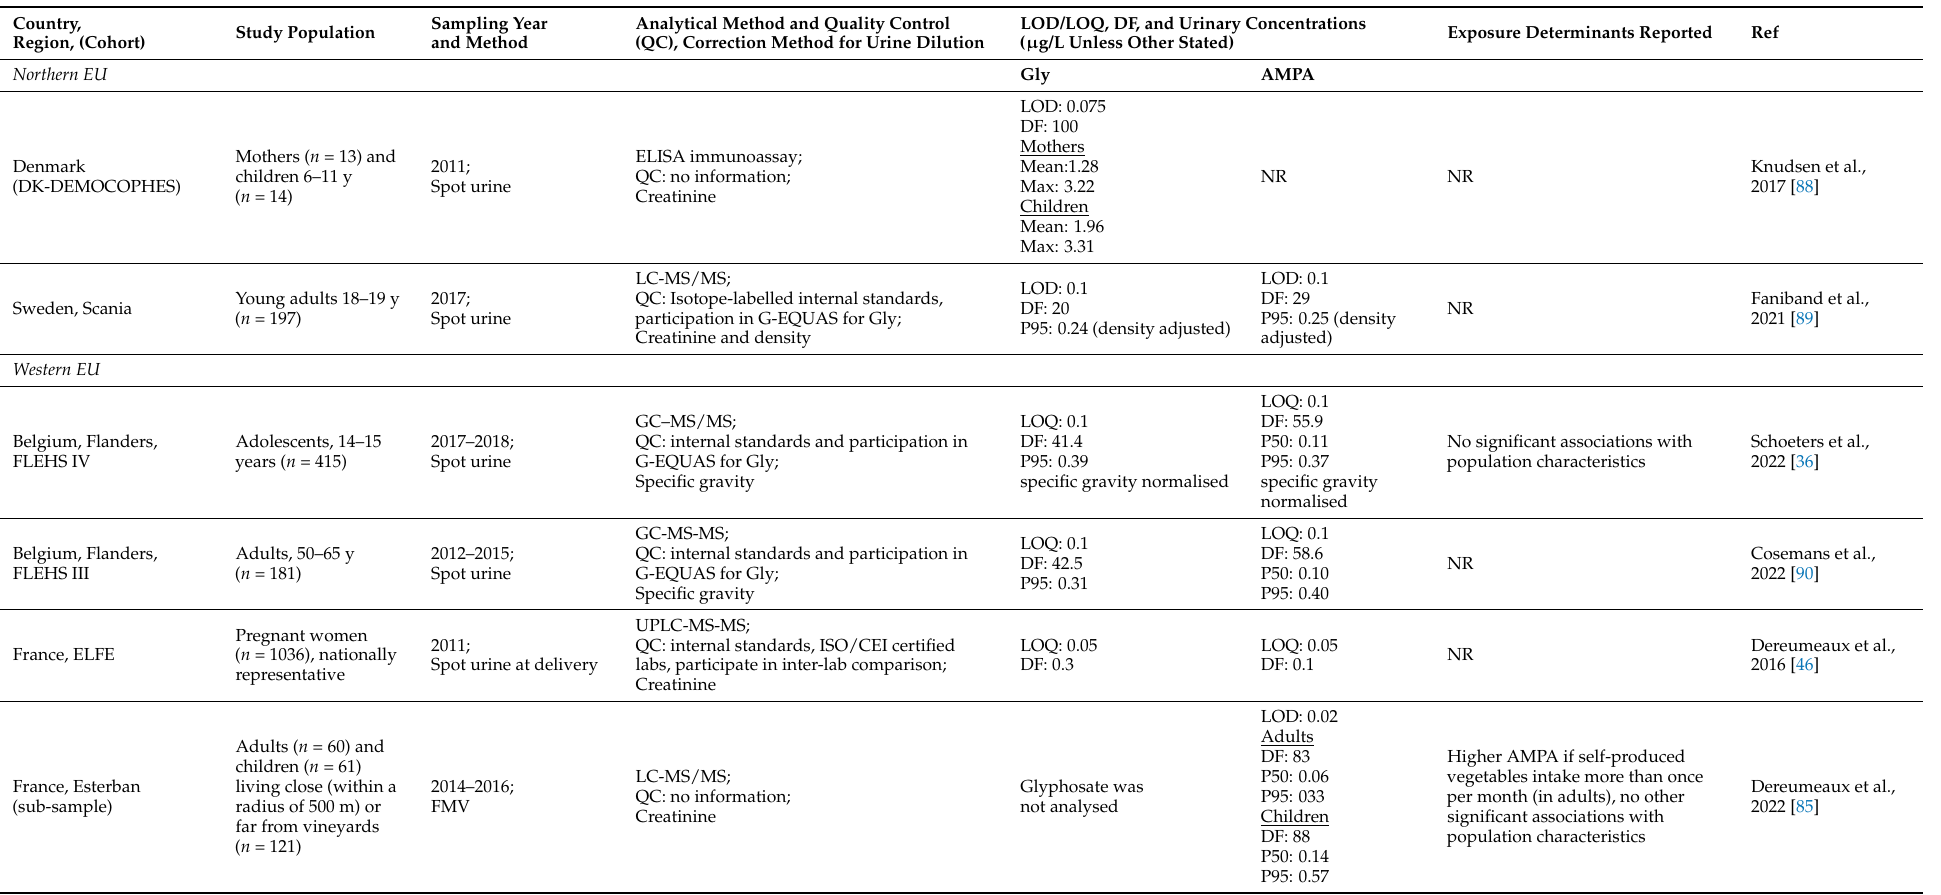
Table 4. Human biomonitoring studies of glyphosate exposure based on urine samples from European